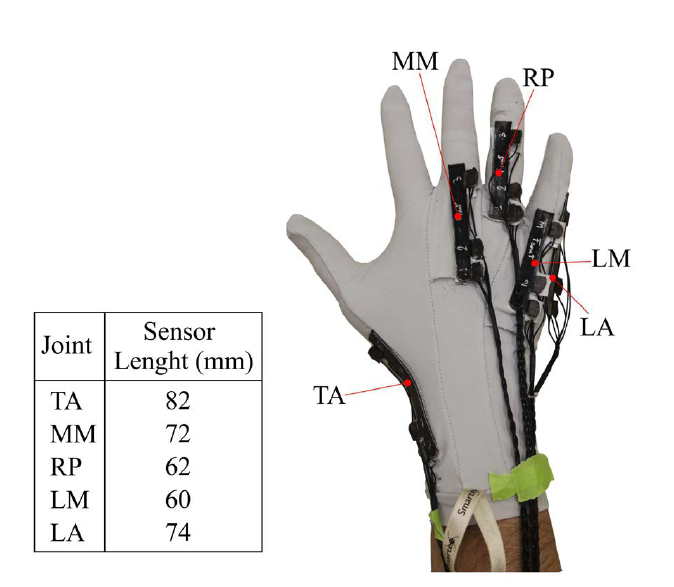
Figure 4. Glove with knitted piezoresistive fabrics (KPF) sensors on the joints of interest.